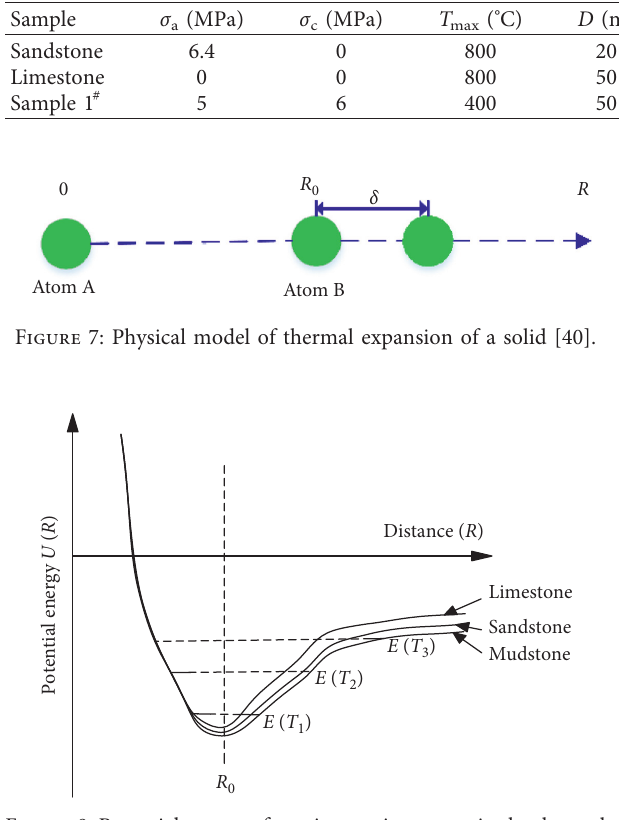
Table 2: Testing data for sandstone and limestone.